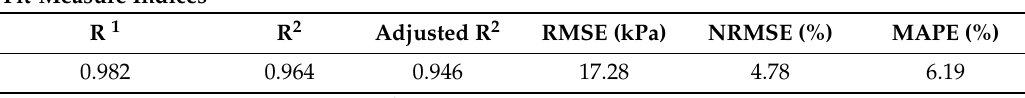
Table 6. Summary of the regression analysis outputs with respect to Equation